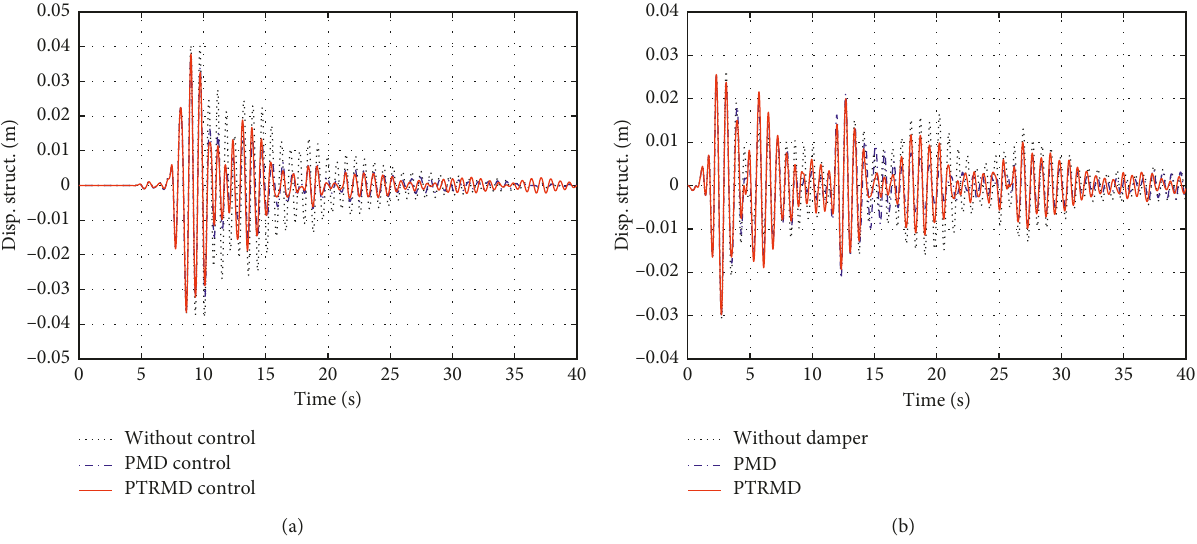
Figure 8: Displacement of the controlled structure under (a) Kobe earthquake and (b) El Centro earthquake.